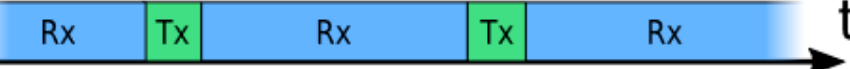
Figure 3. Transmission waveform for a Class C node (own source).